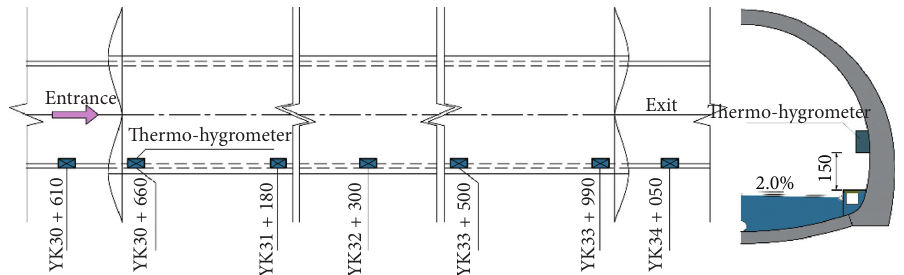
Figure 7: Distribution of thermohygrometers in longitude along the